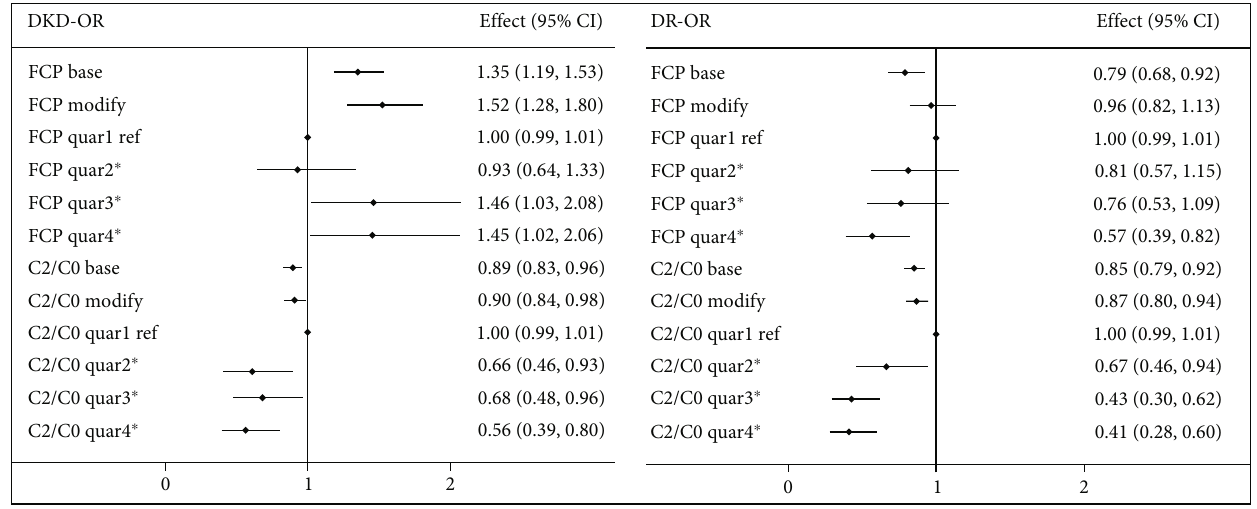
Figure 3: The associations between C-peptide levels and DKD/DR. ∗ P for trend < 0.05. Abbreviations: DKD indicates diabetic kidney disease; DR: diabetic retinopathy; FCP: fasting C-peptide; C2/C0: the ratio of FCP to PCP; Quar: quartile; Ref: reference; CI: con fi dence interval. Modi fi ed model adjusted for age, gender, SBP, HbA1c, TG, TC, HDL, LDL, smoking history, education, duration of diabetes, ever insulin use, and